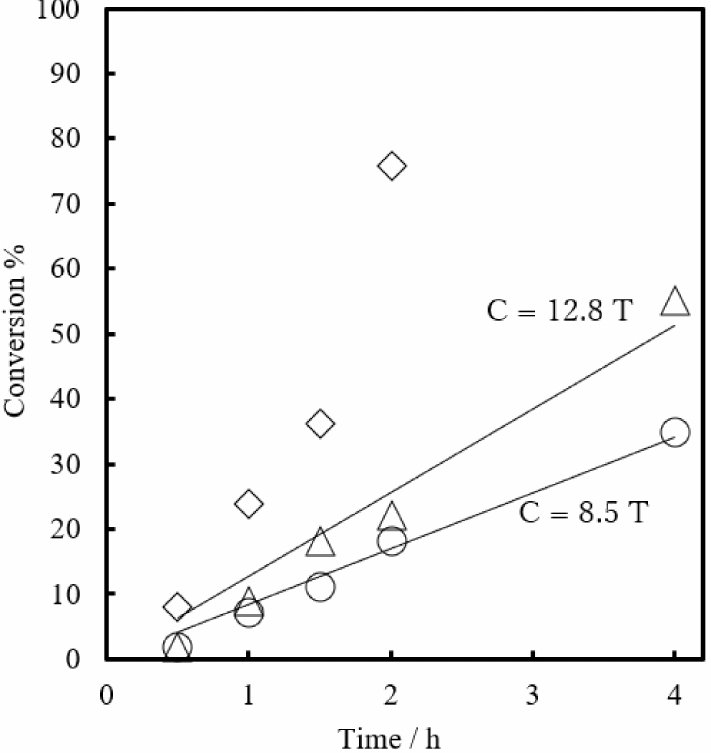
Figure 4. Conversion of phenol as a function of time during reaction with α -ZrP · 0.44DBU ( α -ZrP · 0.22DBU ( (cid:52) ), and α -ZrP · 0.10DBU (